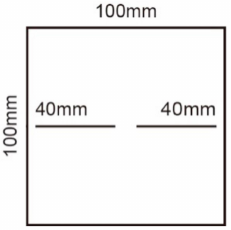
Figure 3. Schematic diagram of joint specimens in scheme